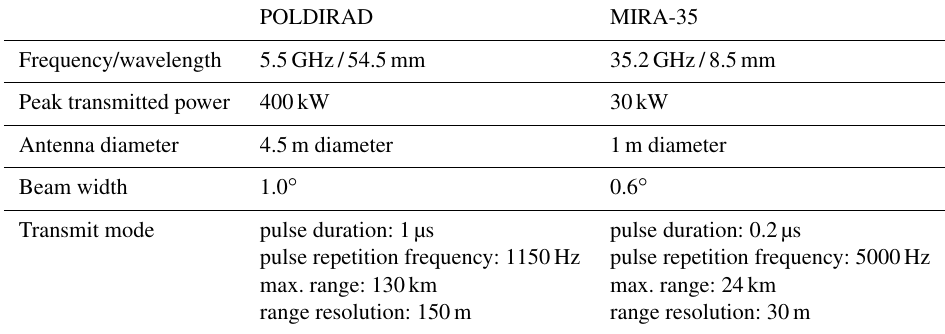
Table 1. POLDIRAD and MIRA-35 technical